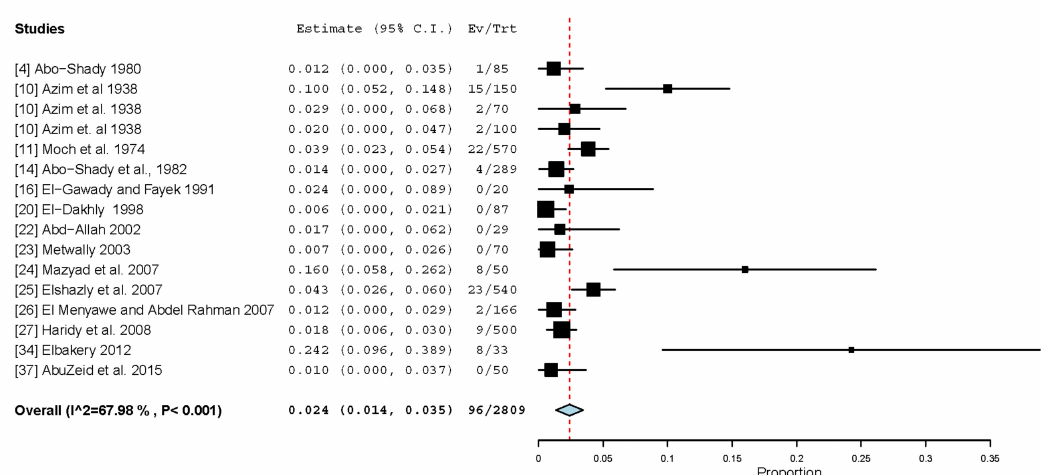
Figure 3. Forest plot diagram for random effects in the meta-analysis of the prevalence of E. granulosus in dogs from Egypt. The length of the line indicates 95% confidence interval of each study and the middle point of each line refers to the prevalence. Diamond refers to the overall prevalence.